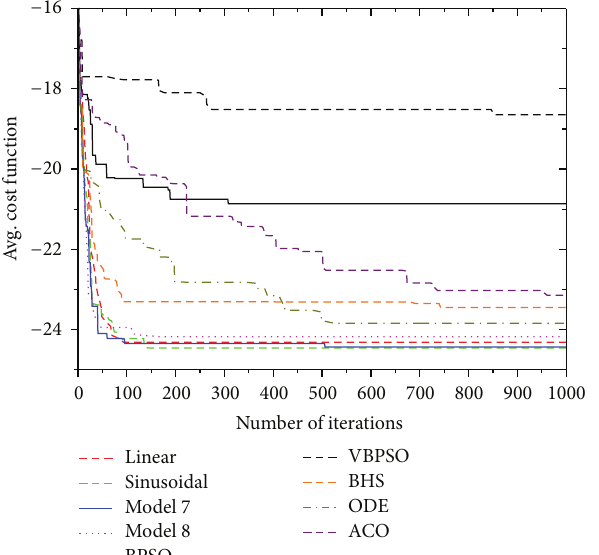
Figure 3: Convergence rate graph for the 300-element symmetric thinned array case with same aperture size.